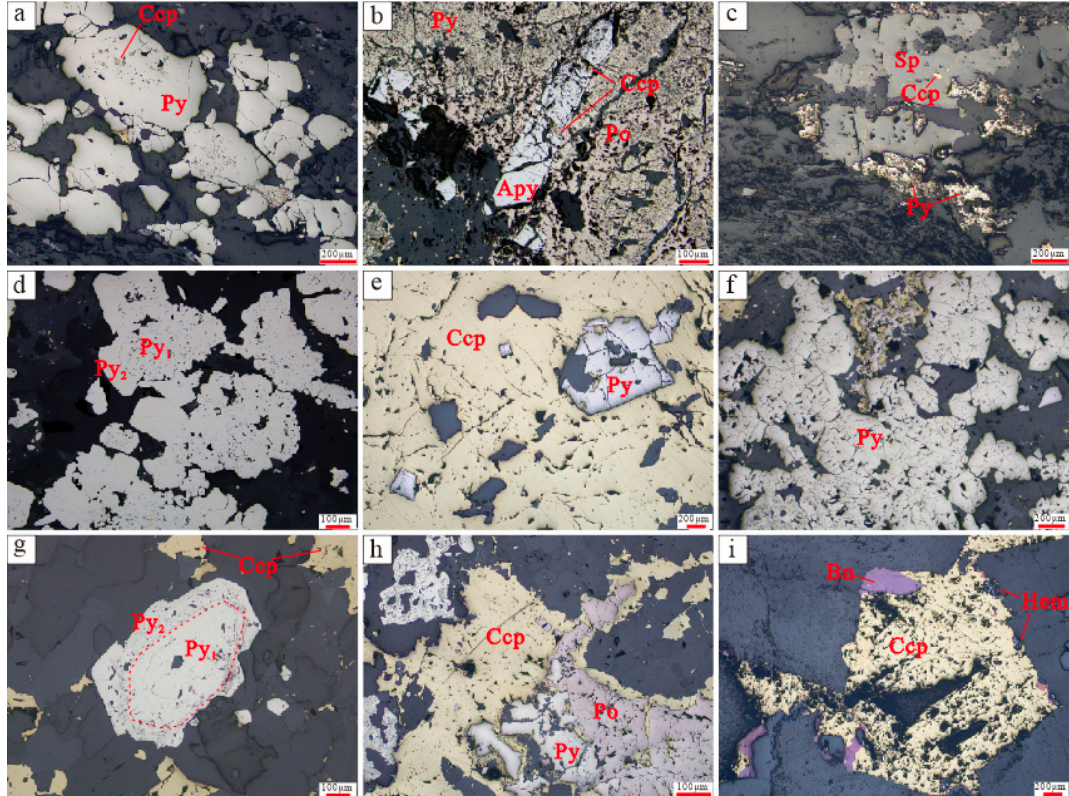
Figure 5. Photomicrographs showing the ore minerals of two types of ores; the laminated ore (Figure 5a–d) and the vein-type ore (Figure 5e–i). ( a ) Subhedral to anhedral pyrites, locally replaced by chalcopyrites; ( b ) arsenopyrite replaced and cut by other sulfides, indicating it was formed earliest; ( c ) chalcopyrite exsoluting from sphalerite; ( d ) late stage pyrite replacing early stage pyrite that include some of the matrix of the rock; ( e ) euhedral to subhedral pyrites enclosed or replaced by chalcopyrite; ( f ) granular pyrite; ( g ) zonal texture of pyrite, suggesting a later hydrothermal event; ( h ) pyrrhotite and pyrite replaced by chalcopyrite; ( i ) chalcopyrite partially replaced by bornite at the margin. Mineral abbreviations: Py, pyrite; Ccp, chalcopyrite; Apy, arsenopyrite; Po, pyrrhotite; Sp, sphalerite; Bn, bornite; Hem, hematite.